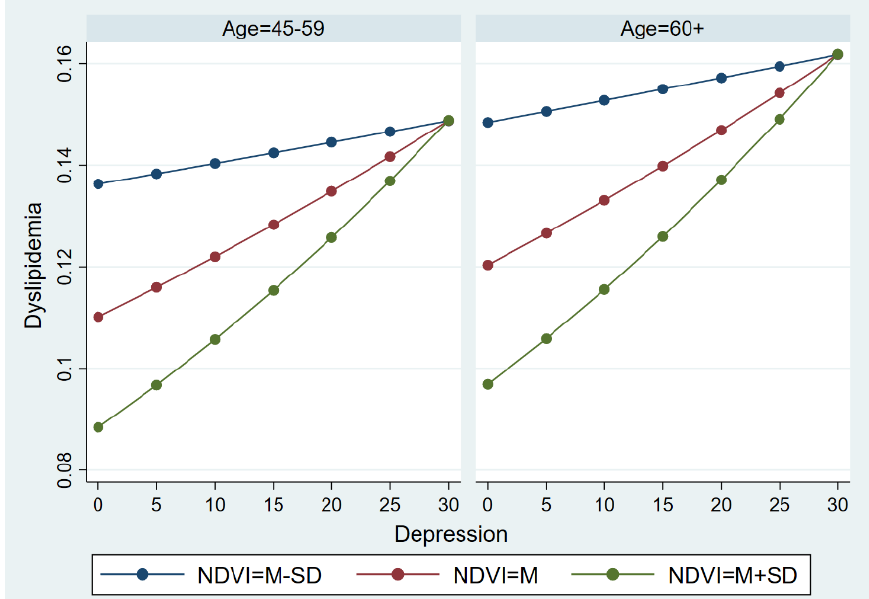
Figure 5. The moderate effect of NDVI on the relationship between depression and dyslipidemia across age groups.